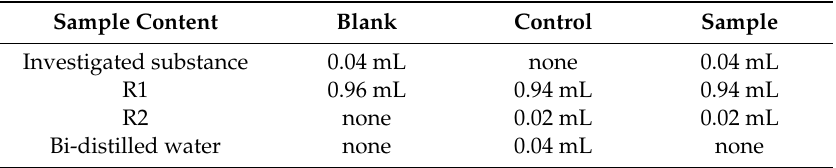
Table 3. Sample composition for the ABTS • + assay.